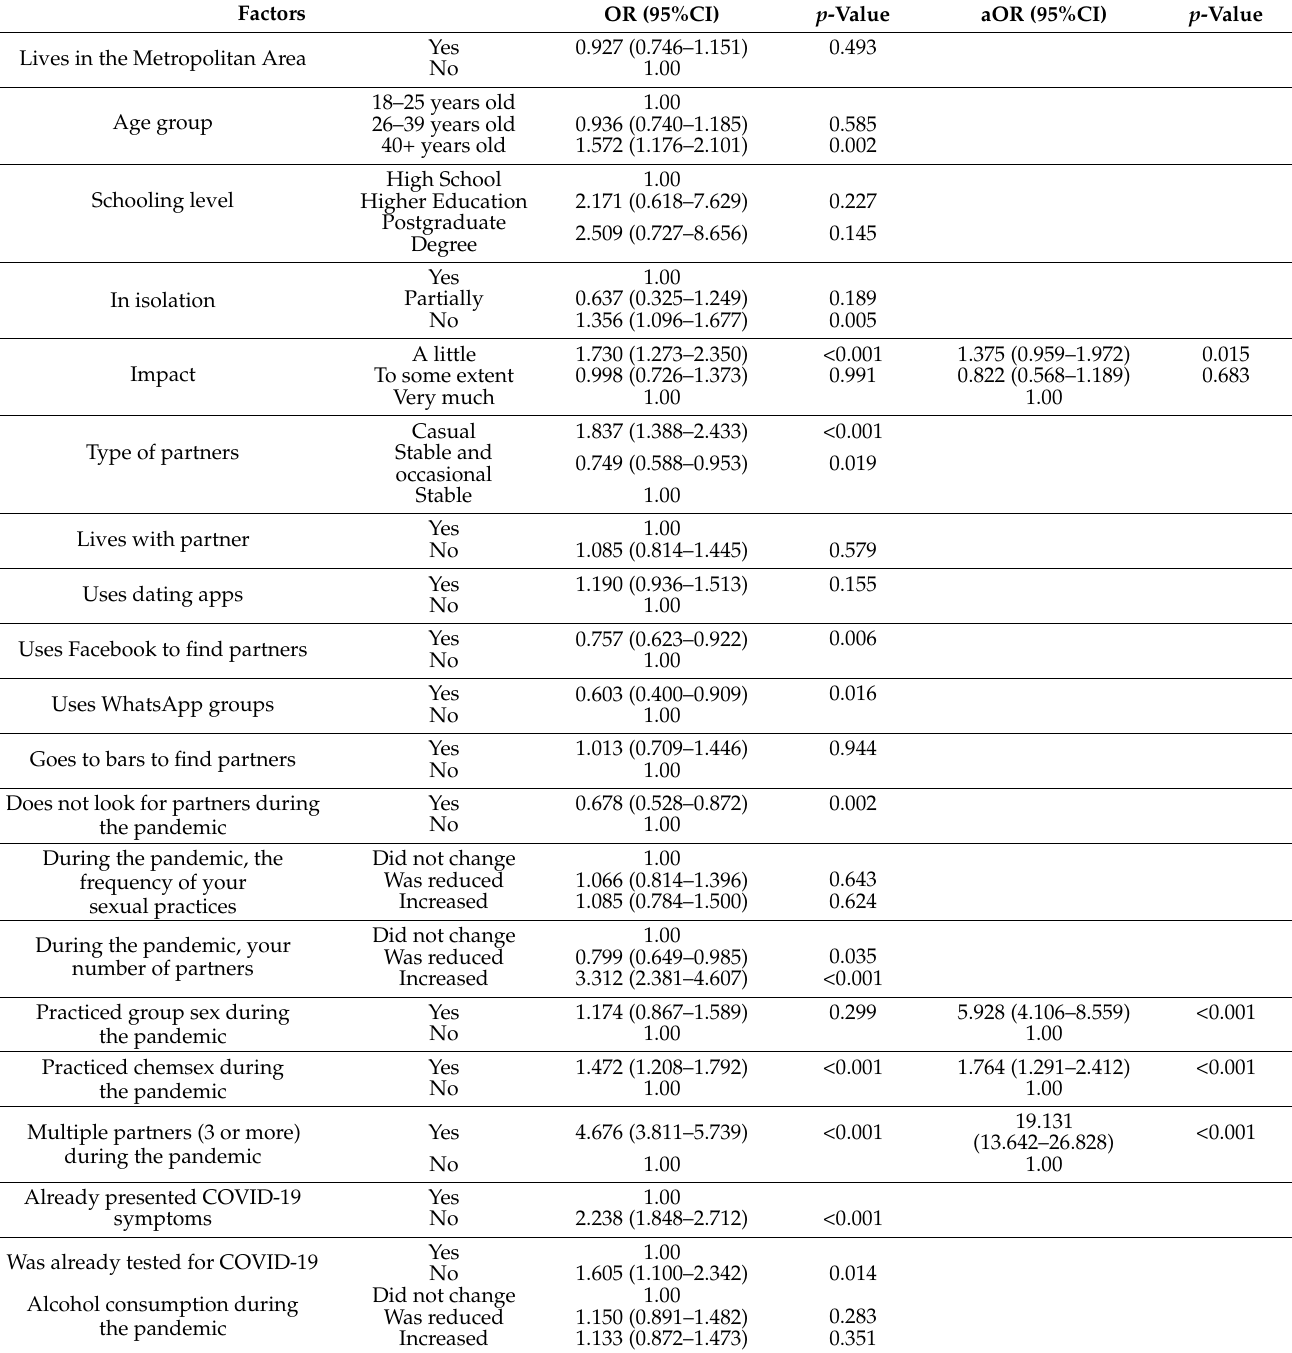
Table 3. Bivariate and multivariate analysis considering the factors associated with at-risk sexual exposure during the pandemic among the individuals living in Brazil,